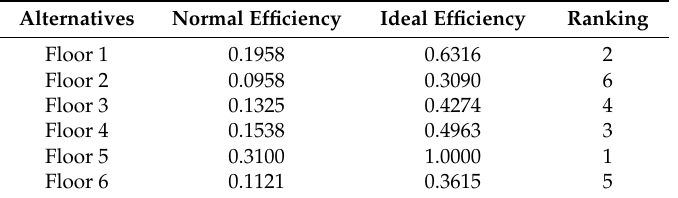
Table 5. DEA–Charnes, Cooper and Rhodes and assurance regions (CCR/AR) model